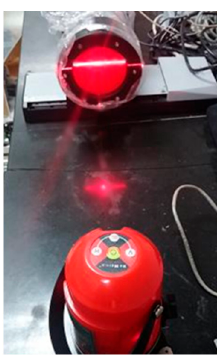
Figure 12. Horizontal calibration experiment.